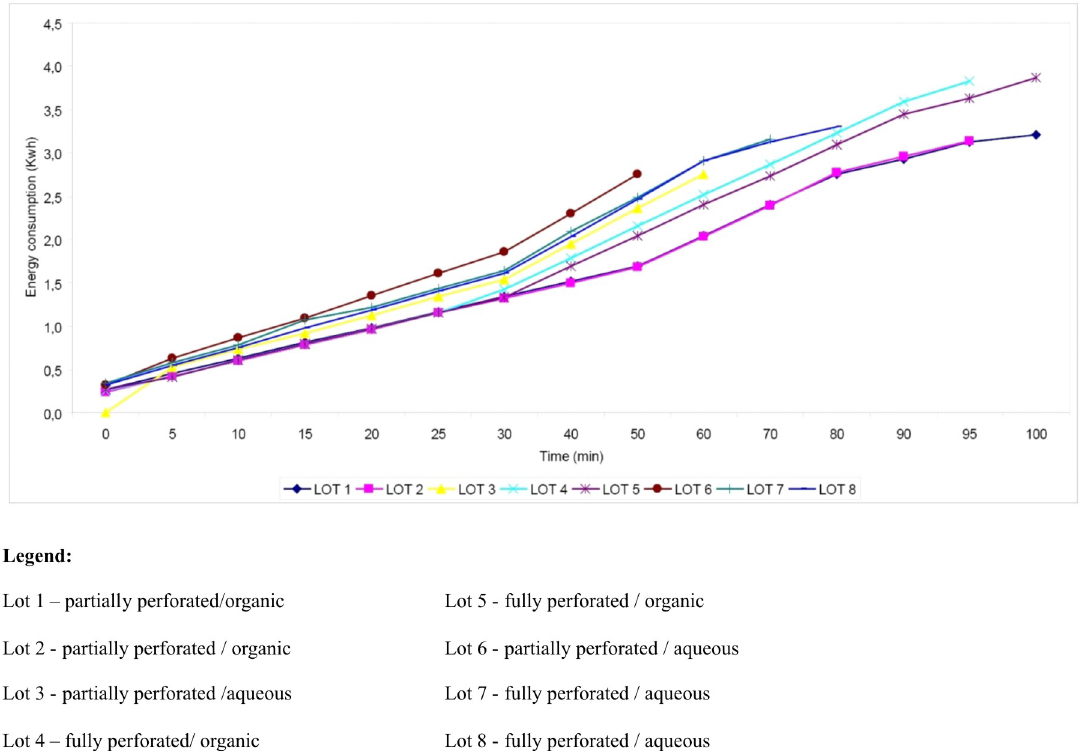
FIGURE 1 - Energy consumption graph as a function of time for lots 1-8 during core coating step.